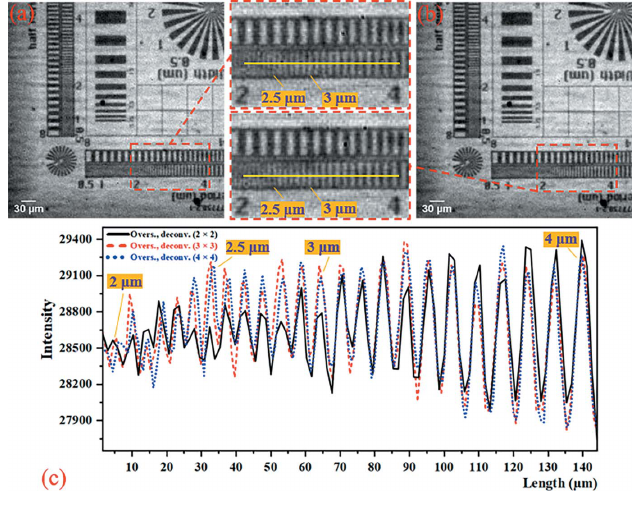
Figure 9 Results of the 3 (cid:2) 3 and the 4 (cid:2) 4 mode SRX experiments. ( a ) The 3 (cid:2) 3 mode oversampled image with deconvolution (pixel size: 0.98 m m (cid:2) 0.98 m m; pixel number: 444 (cid:2) 444). ( b ) The 4 (cid:2) 4 mode oversampled image with deconvolution (pixel size: 0.735 m m (cid:2) 0.735 m m; pixel number: 592 (cid:2) 592). Similarly, panels ( a ) and ( b ) are only part of the image to show the details more clearly. ( c ) The intensity profiles at the yellow line (the line-width between 2 m m and 4 m m) in 2 (cid:2) 2, 3 (cid:2) 3 and 4 (cid:2) 4 micro-scanning